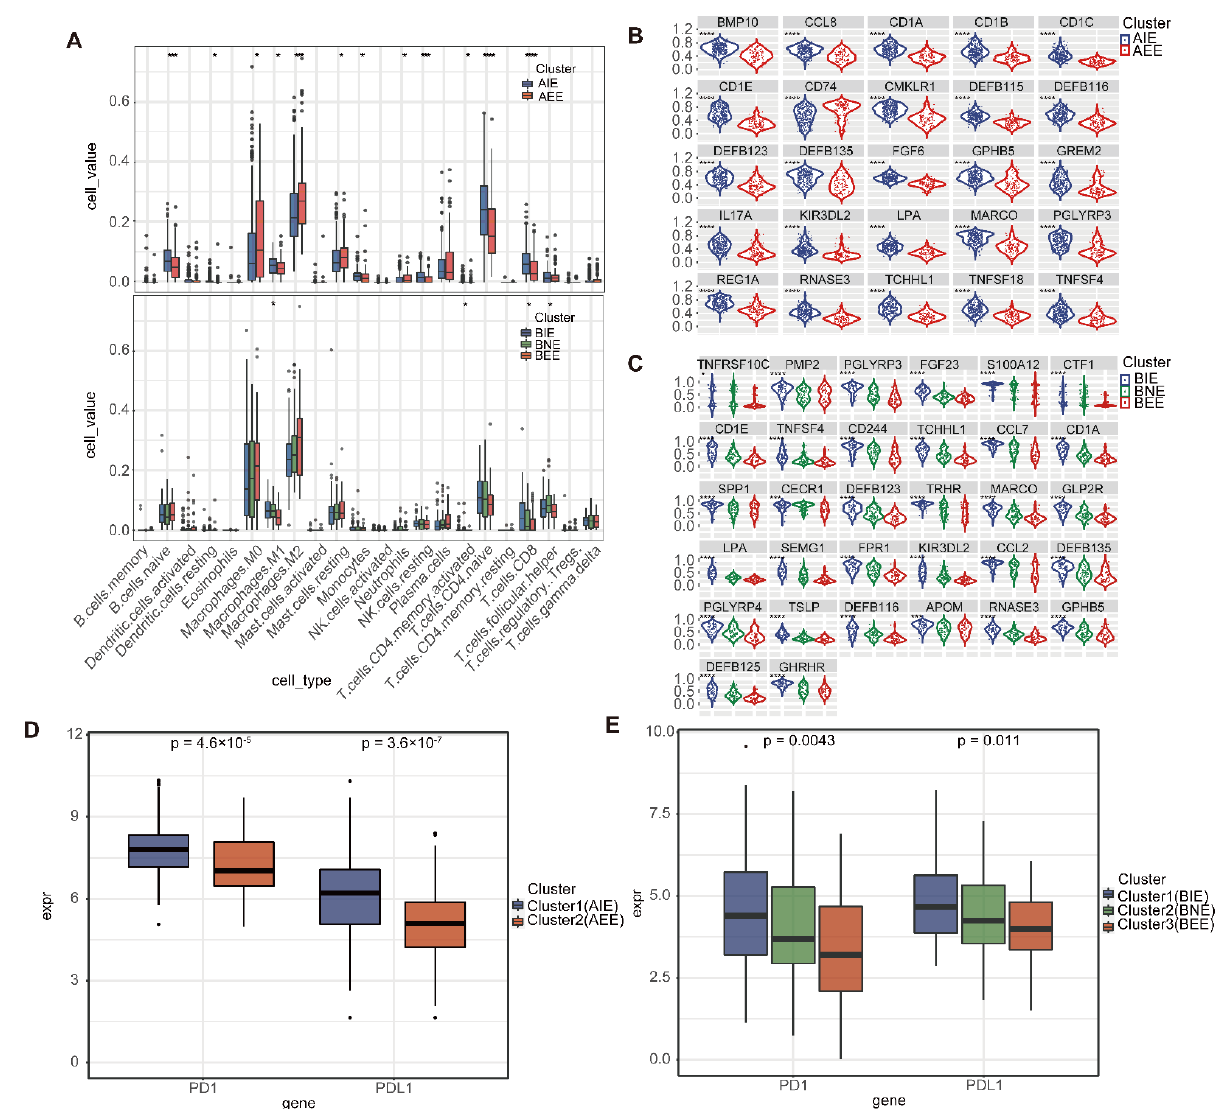
Figure 4. The immune microenvironment in luminal A/B subgroups. ( A ) Comparison of 22 kinds of immune cells infiltration ratio between subgroups. ( B ) Comparison of DNA methylation of specific immune genes between luminal A subgroups. ( C ) Comparison of DNA methylation of specific immune genes between luminal B subgroups. ( D ) The expression of PD1/PDL1 of subgroups in luminal A. ( E ) The expression of PD1/PDL1 of subgroups in luminal B. (* p < 0.05. ** p < 0.01. *** p < 0.001. **** p < 0.0001.).